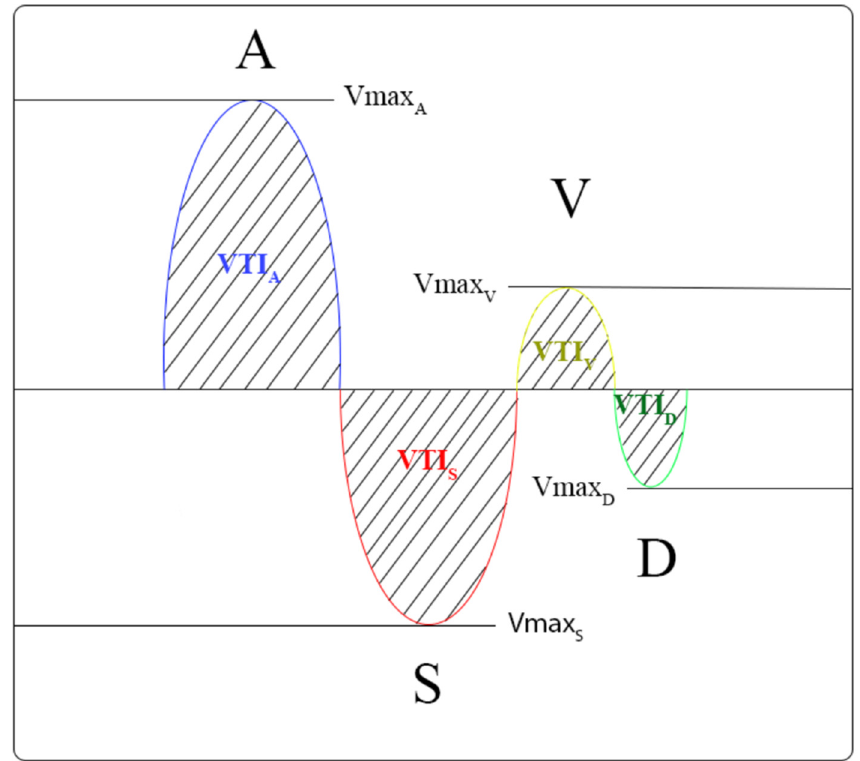
Figure 3. Doppler ultrasound analysis of the hepatic veins–maximum velocity and velocity-time integral were measured (a line was adjusted to the maximum point and continuous wave Doppler’s spectral curve was calculated by the machine. A and V waves are retrograde, S and D are anterograde waves).